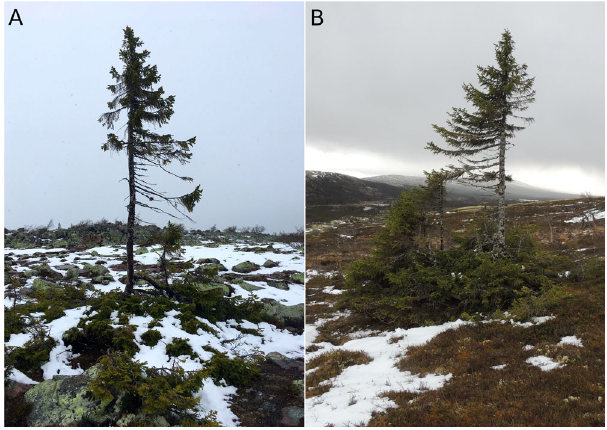
Fig. 1 Clonal spruce trees from Dalarna County in Sweden. A Old Tjikko spruce with the oldest fossil remains dated 9.5 cal. kyr BP. B